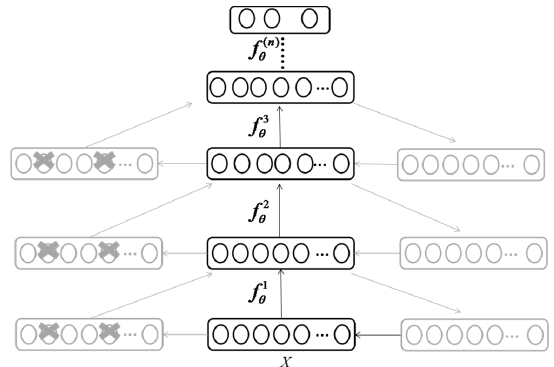
Figure 2. Process of SDAE training.